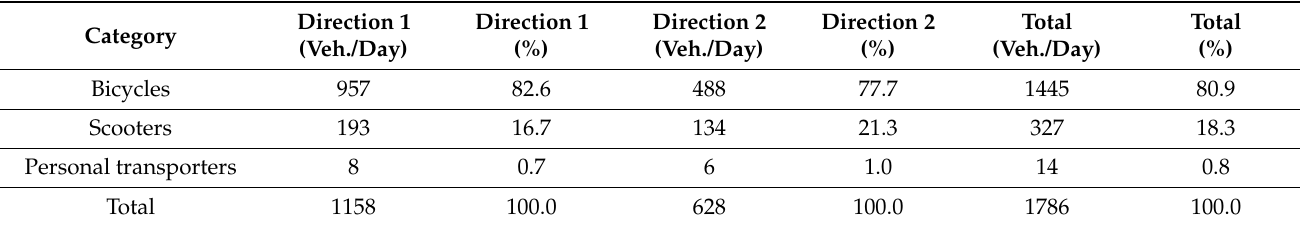
Table 3. Vehicle structure type at the bicycle lane along ´Swi˛etokrzyska street, broken down by directions (own study).